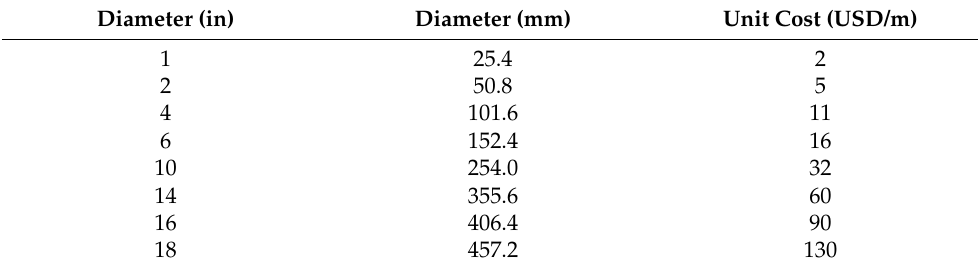
Figure 6. The Two-loop network layout. Table 4. Available pipes for selection for the Two-loop network.